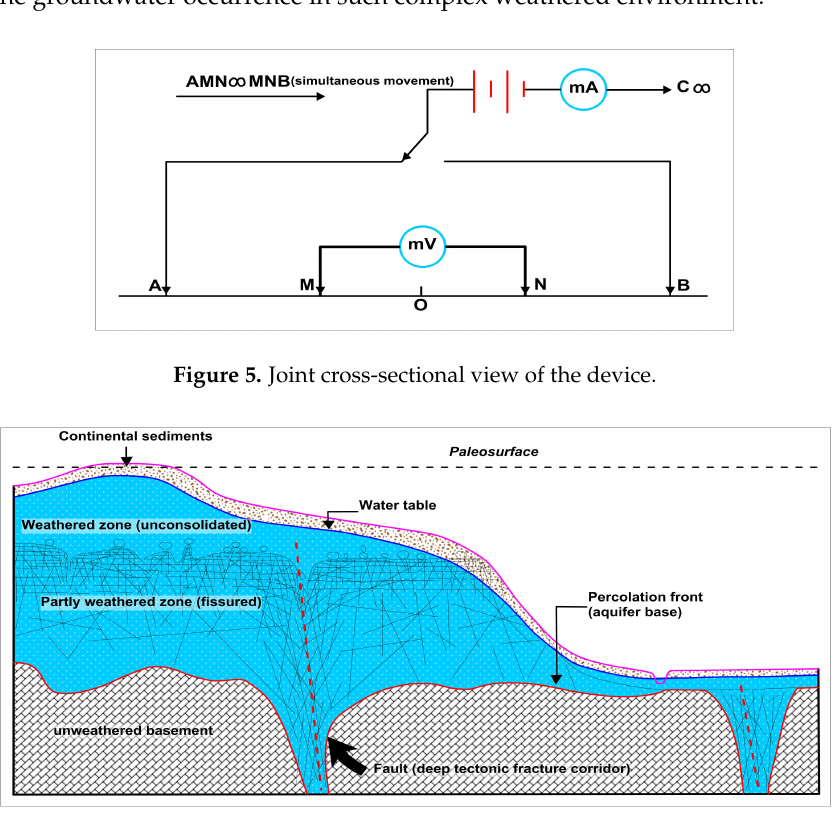
Figure 6. Conceptual model of hydrogeological properties in weathered basement rock (modified after